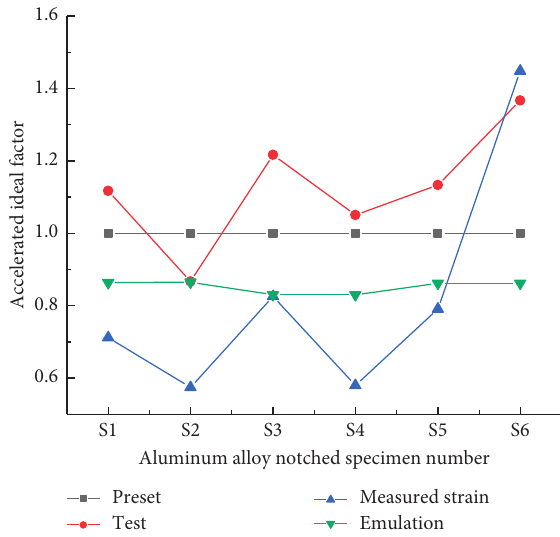
Figure 18: Comparison of ideal factors of the bench test and simulation